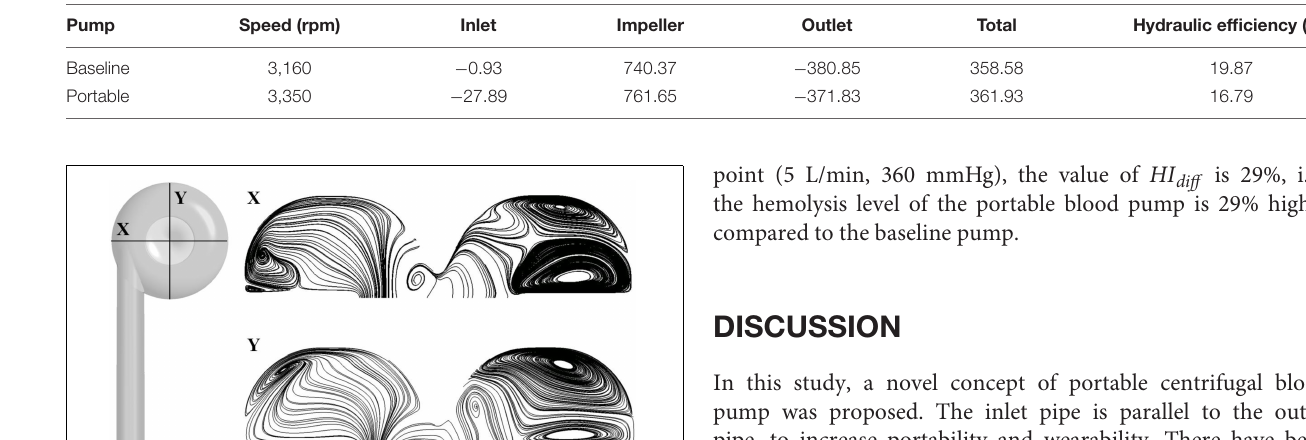
TABLE 5 | Pressure head in different portions of the two pump models, in mmHg.